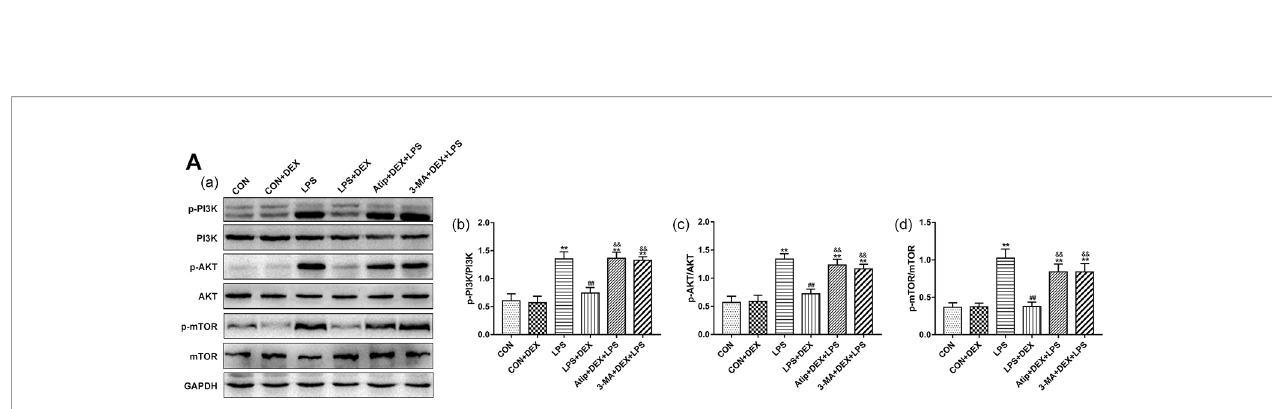
FIGURE 8 | Effects of DEX treatment on the PI3K/AKT/mTOR pathway. (A) Representative blots (a), and densitometry of p-PI3K/PI3K (b), p-AKT/AKT (b), and p- mTOR/mTOR (c) signals. Data are expressed as mean ± SEM (n = 6). **p < 0.01 versus CON group. ##p < 0.01 versus LPS group. &&p < 0.01 versus DEX + LPS